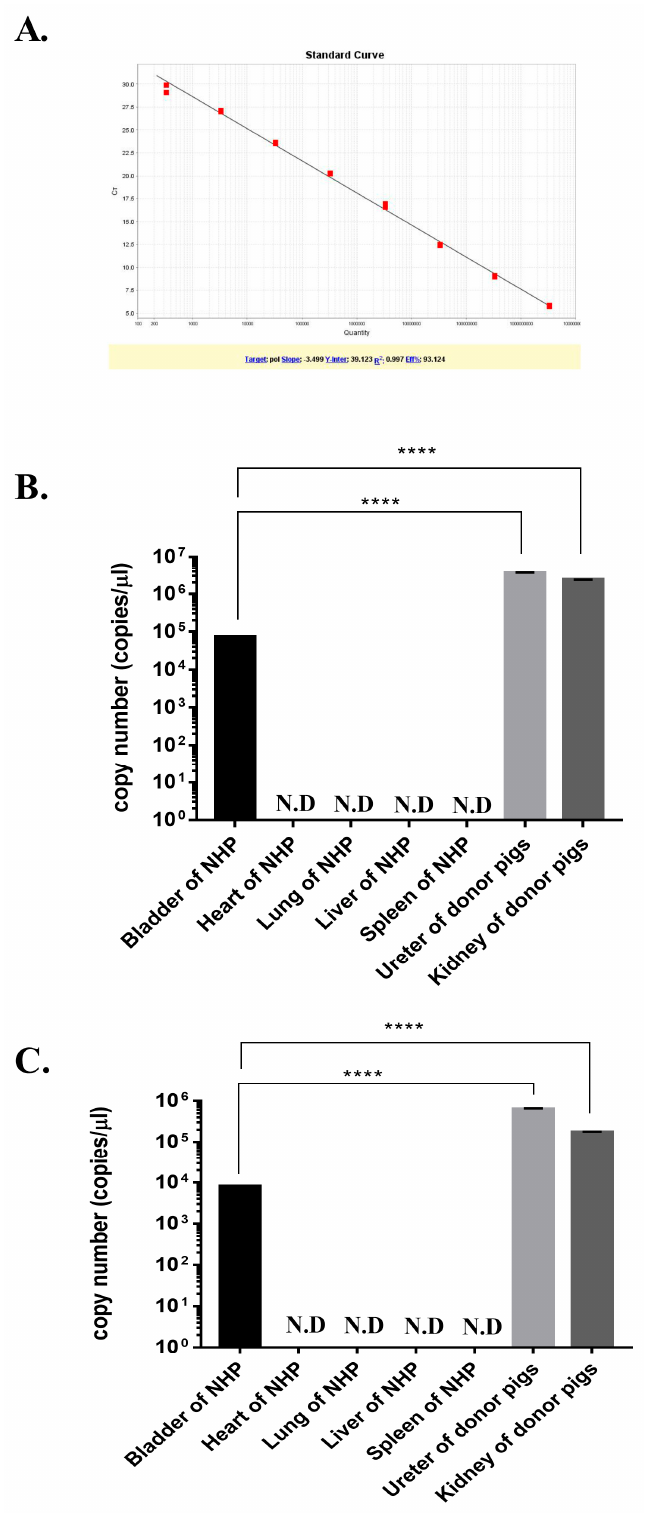
Figure 3. Quantitative analysis of PERV pol gene by real-time PCR. Quantitative real-time PCR was performed to detect the pol gene of PERV in tissues. ( A ) A typical standard curve derived from a serial dilution of standard plasmid DNA. ( B ) Copies / µ L of PERV pol in gDNA, ( C ) Copies / µ L of PERV pol in cDNA. Values are presented as means ± SD based on three tissues. (**** p < 0.0001 for comparison between the two groups).